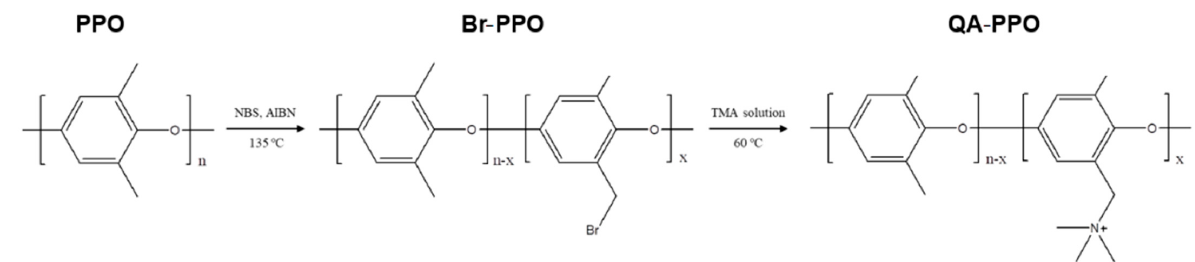
Figure 1. Scheme of the polyphenylene oxide containing quaternary ammonium (QA – PPO).